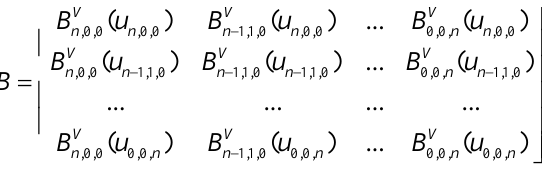
Table 1. Models of test cases